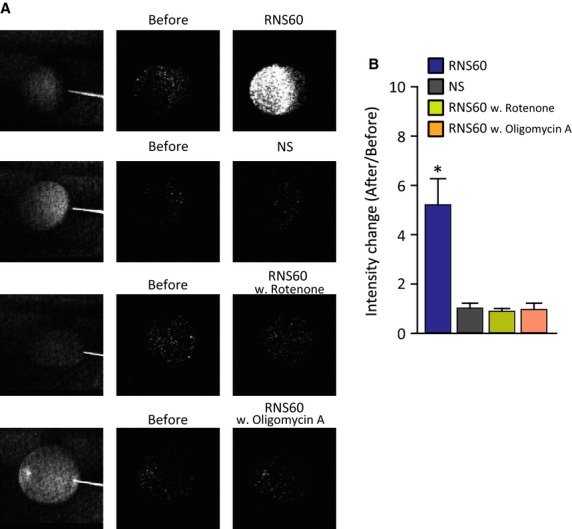
Intracellular ATP levels determined by luciferin/luciferase photon emission in Xenopus laevis oocytes. ATP levels increased 5 min following RNS60-based Ringer's superfusion, but not so following RNS-based Riger's with intracellular ATP blockages (with rotenone and oligomycin A) as well as NS-based Ringer's superfusion (A). Photon ATP images were obtained by photon accumulation for 1 min. Scale bar = 0.5 mm. Statistical difference is shown in (B). *P < 0.05 by one-way ANOVA. (n = 8 in RNS60, 6 in NS, 4 in RNS60 with rotenone, and 5 in RNS60 with oligomycin A).